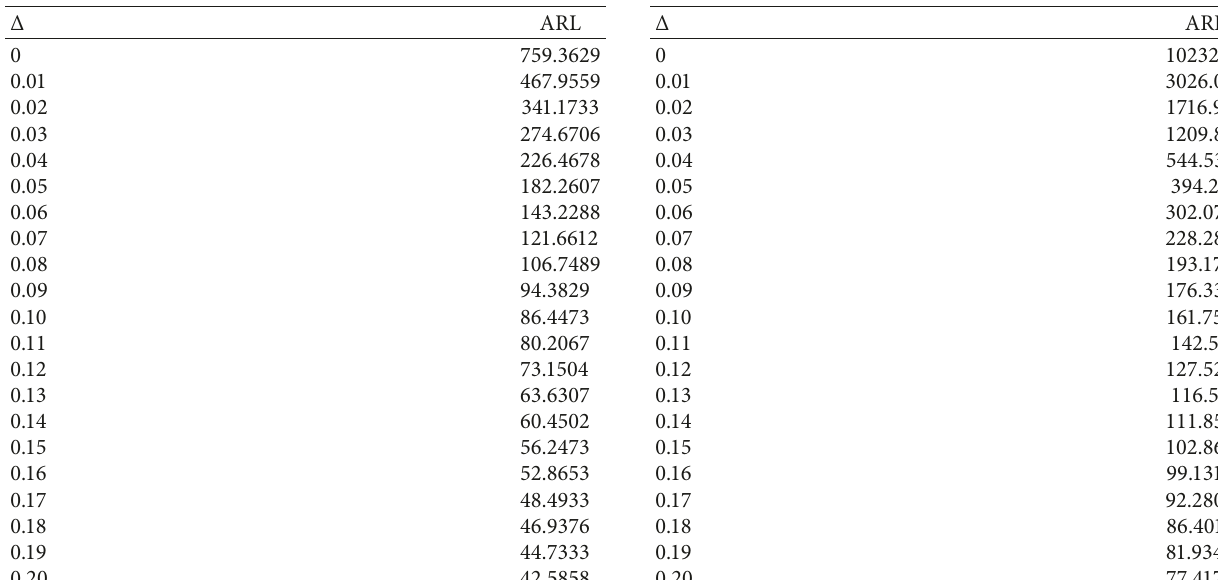
Table 3: Impact of estimation error for R